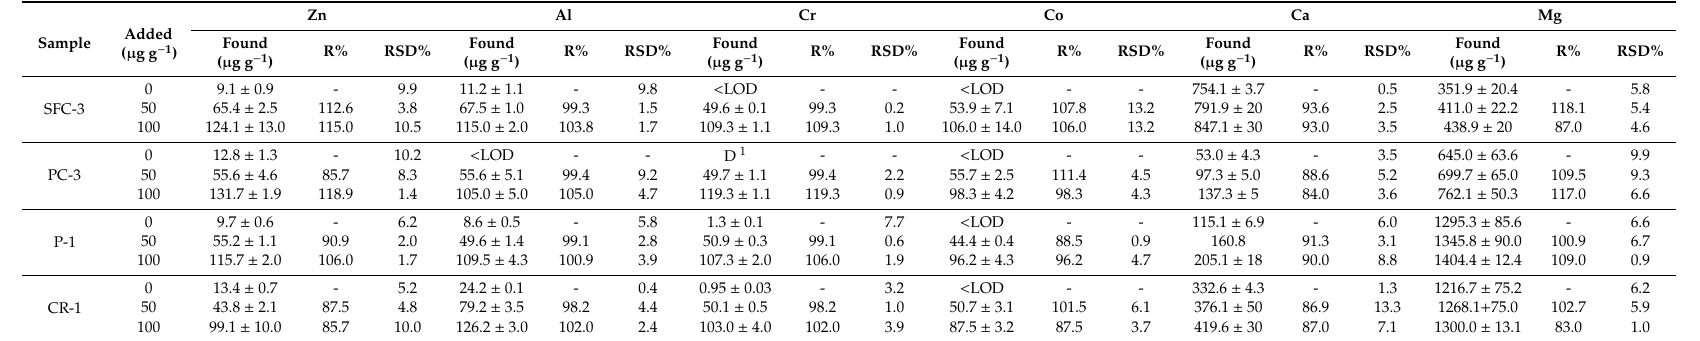
Table 5. Relative recoveries and RSD% values for Zn, Al, Cr, Co, Ca and Mg for the analysis of spiked savory snack samples.